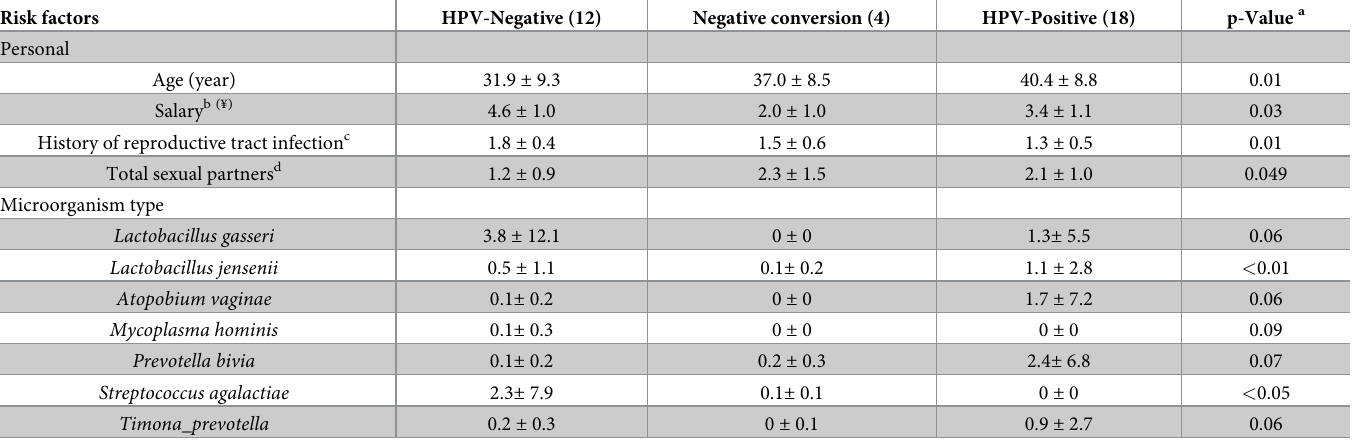
Table 1. Significant or pseudo-significant characteristics of the